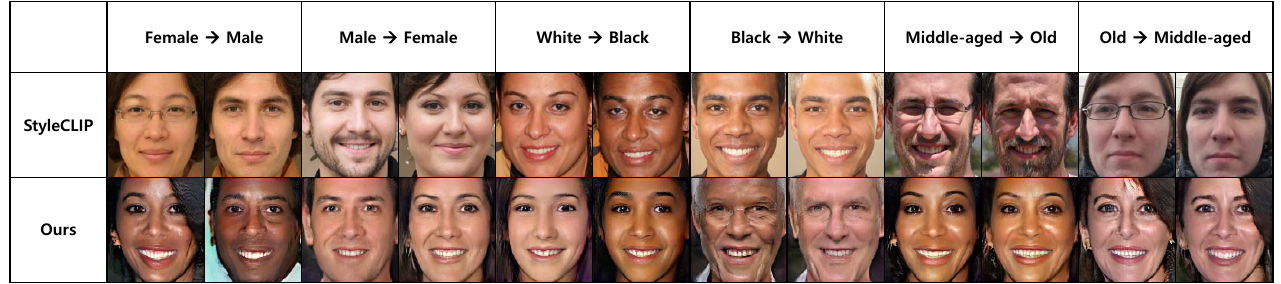
Figure 12. Comparison 2: identity